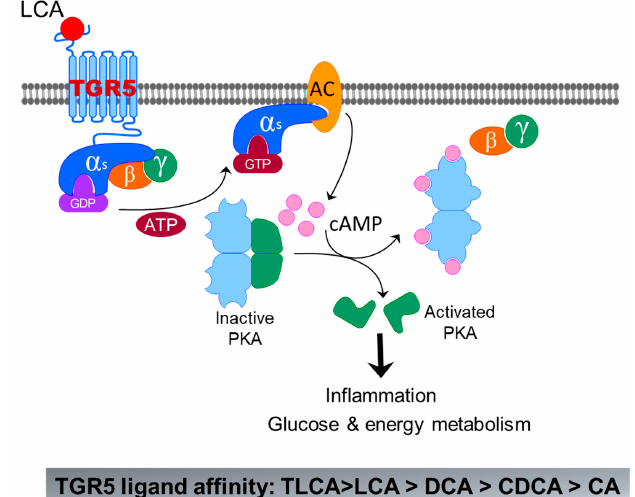
Figure 6. Bile-acid-induced activation of TGR5. The binding of LCA to TGR5 induces activation of G α s, which further activates adenyl cyclase (AC) m followed by activation of protein kinase A (PKA) by cAMP. Activated PKA can activate a lot of signaling pathways related to inflammation, glucose, and energy metabolism.